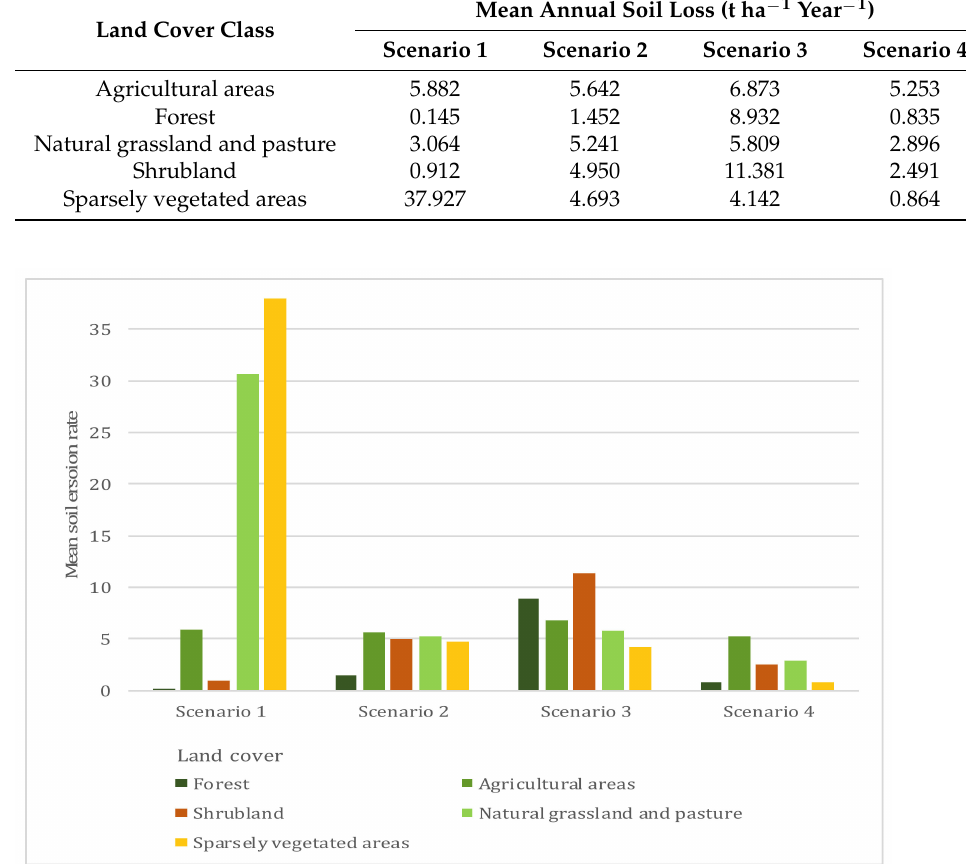
Figure 19. Bar diagram showing soil erosion rates in terms of land